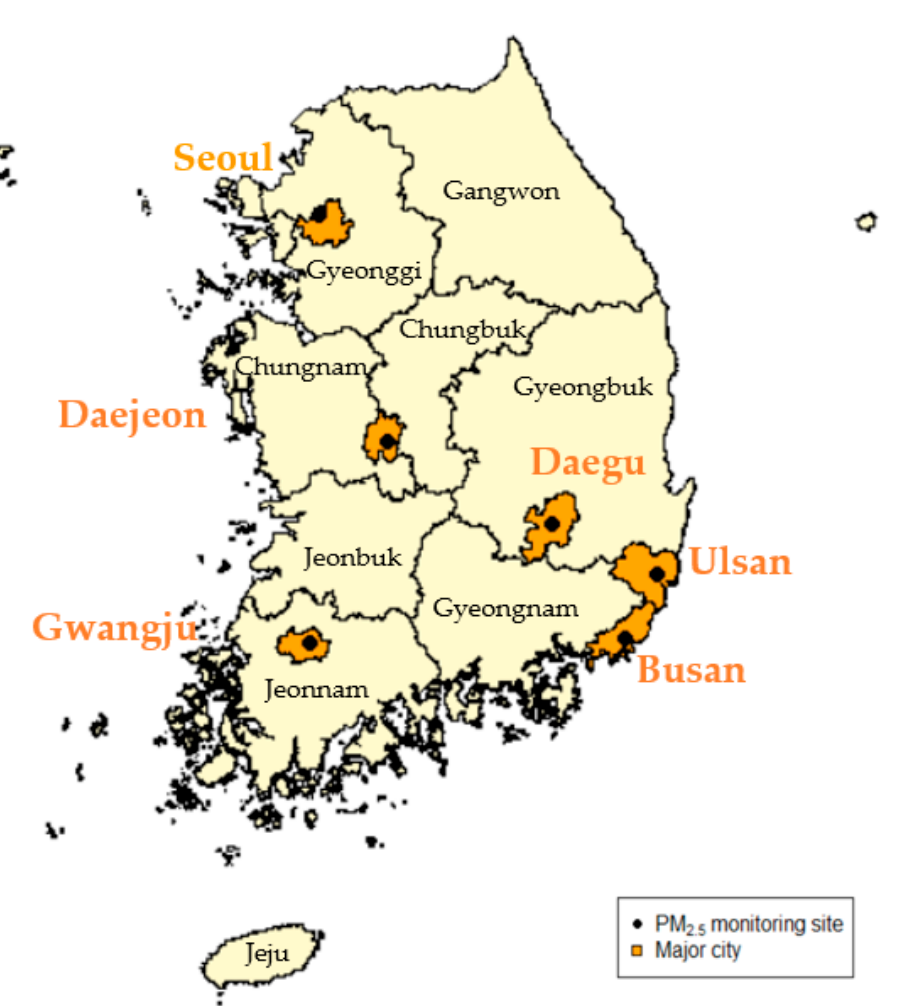
Figure 1. Map of the six major cities (Seoul, Daejeon, Gwangju, Daegu, Ulsan, and Busan) and six PM 2.5 speciation network monitoring sites in South Korea (nine provinces in black: Gyeonggi, Gangwon, Chungbuk, Chungnam, Gyeongbuk, Gyeongnam, Jeonbuk, Jeonnam, and Jeju).